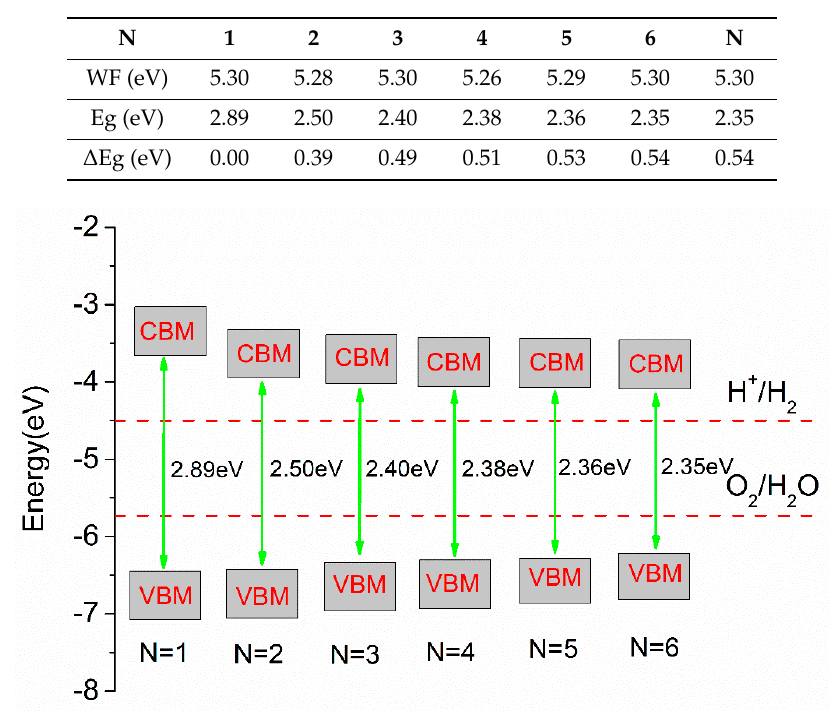
Figure 6. Band-edge potentials of multilayer g–C 8 N 6 compare to standard water redox